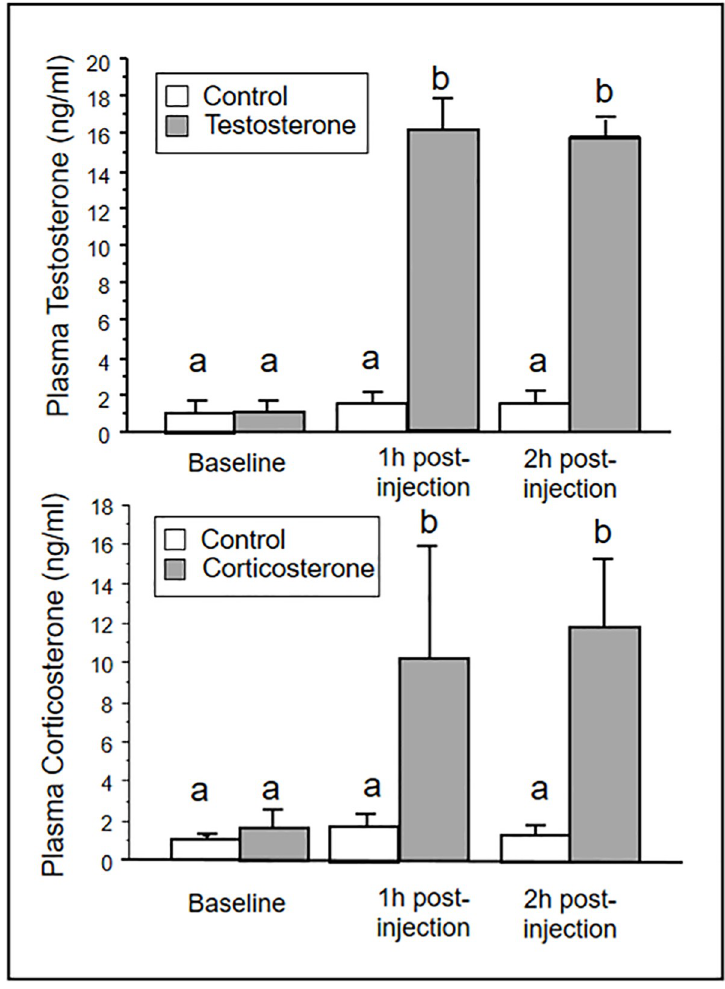
Fig 1. Testosterone and corticosterone concentrations in plasma before and after an injection with testosterone (n = 7, 1.5mg in 0.5ml peanut oil), corticosterone (n = 7, 1.5mg in 0.5ml peanut oil), or control oil (n = 7, 0.5ml peanut oil). Letters above bars indicate significant differences. Bars indicate means ±